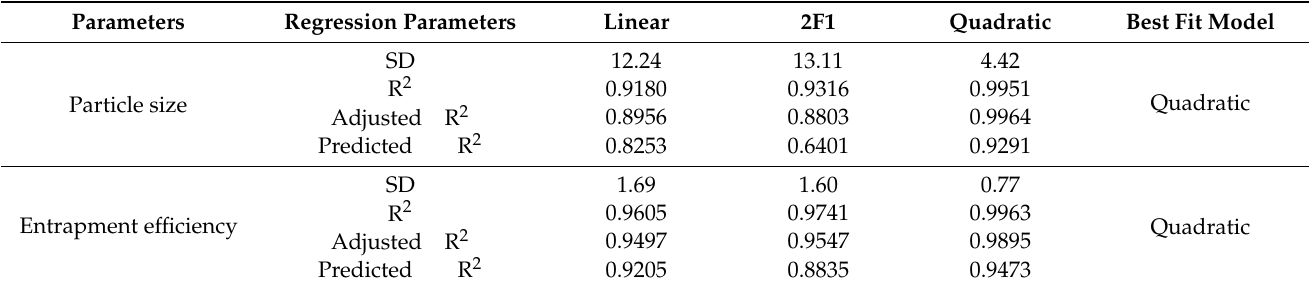
Table 3. Statistical model fit summary report of hybrid nanoparticles.